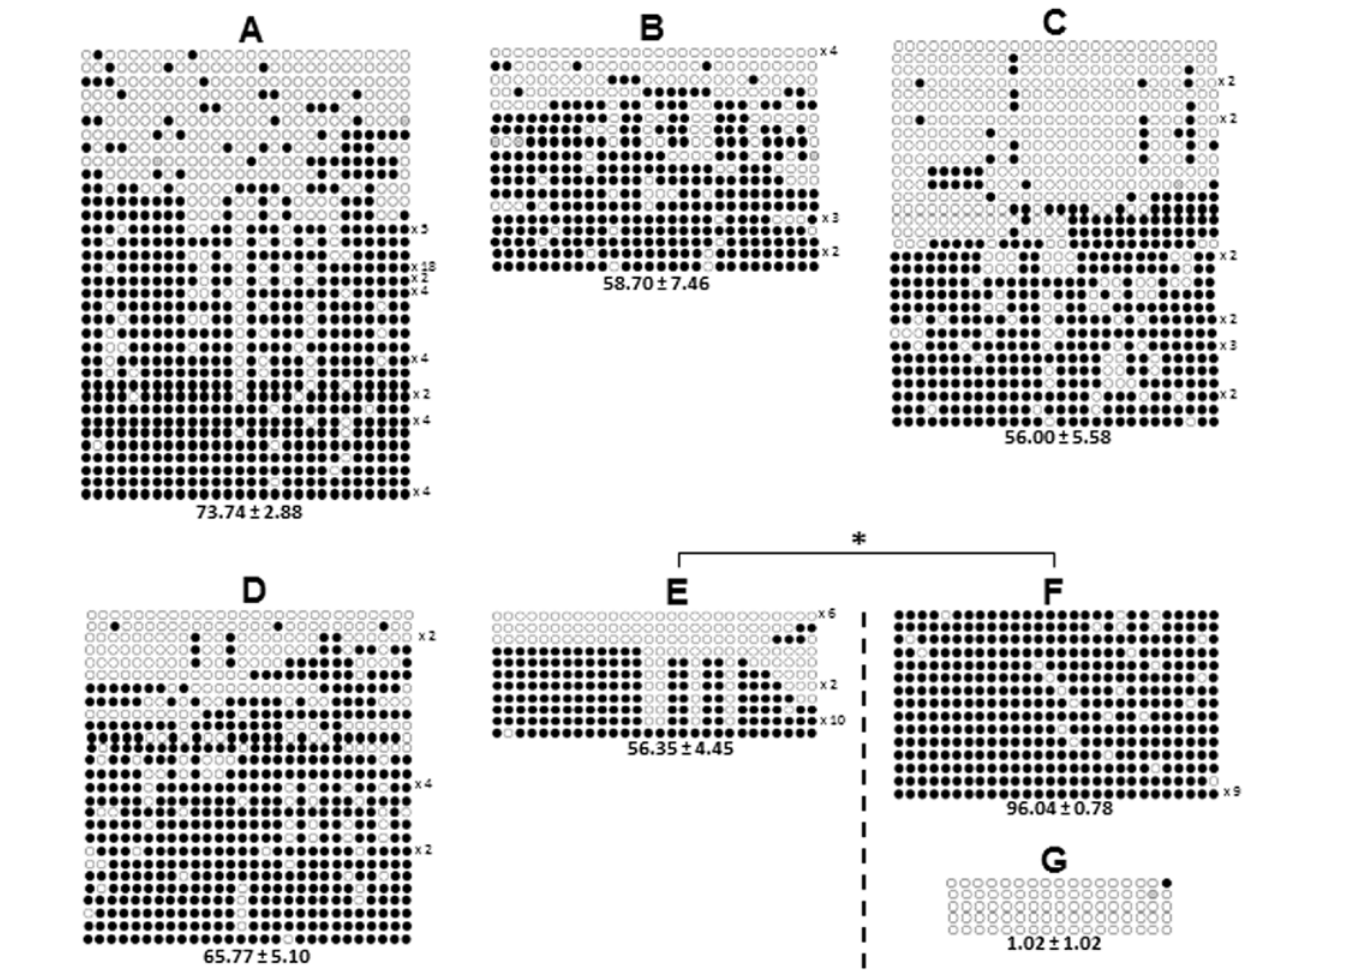
Fig 2. Dynamics of DNA methylation on the last exon of the IGF2 gene from oocytes during bovine folliculogenesis. Letters A-E represent the oocyte groups and F and G spermatozoa. (A) Oocytes from primordial follicles; (B) oocytes from final secondary follicles; (C) oocytes from small antral follicles; (D) oocytes from large antral follicles; (E) matured MII oocytes; (F and G) matured spermatozoa. A-F show the methylation profile on the last exon of IGF2 and G shows the methylation profile on the exon 1 of the XIST. Each line represents one individual clone and each circle represents one CpG dinucleotide (28 CpGs for IGF2 and 17 CpGs for XIST). White circles represent unmethylated CpGs, filled black circles represent methylated CpGs and gray circles represent a CpG that could not be analyzed. The numbers to the right of each clone indicate the number of times that the allele was sequenced and the numbers to the bottom of each group represent the DNA methylation means ± standard errors for each group. ( * ) represent significantly different means ( p (cid:3) 0.05). XIST was used as unmethylated control.